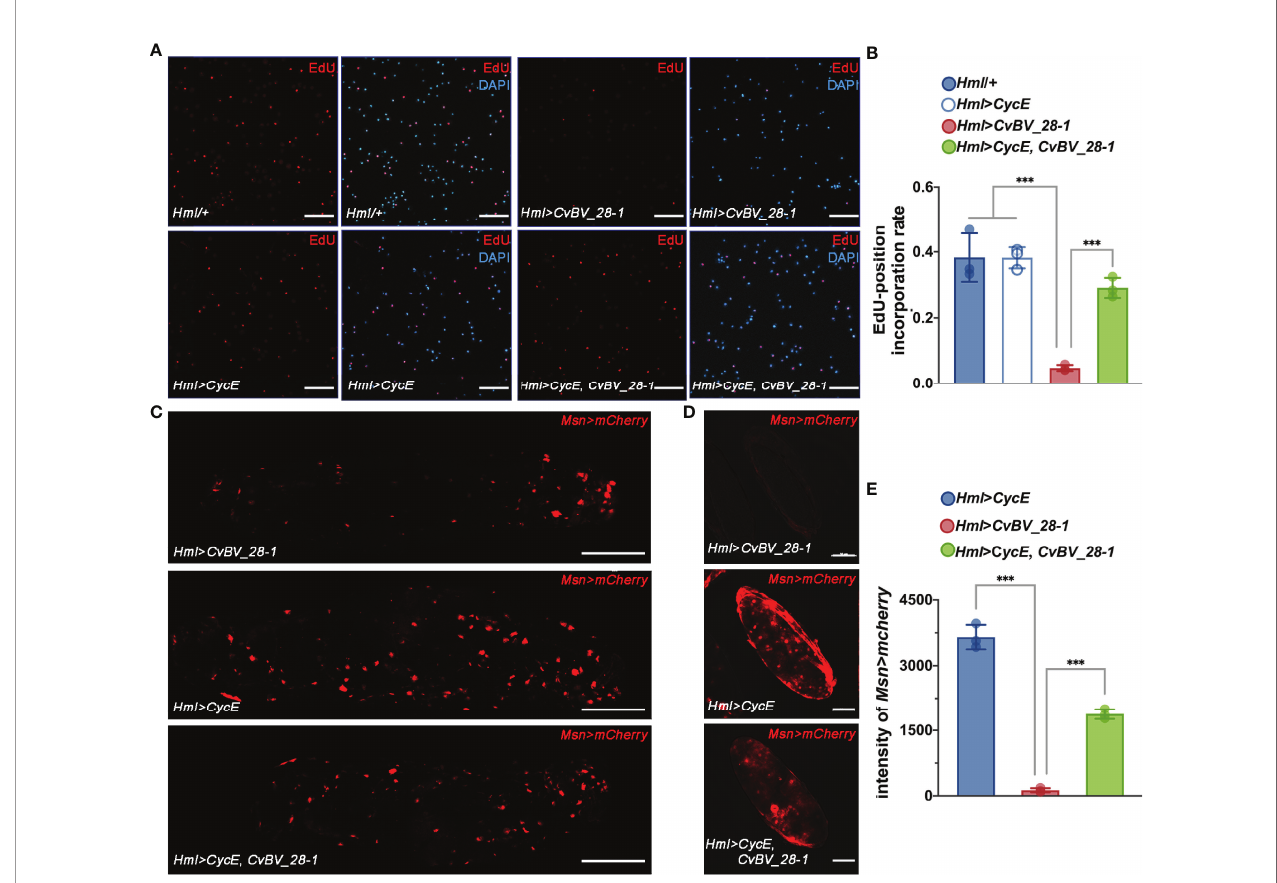
FIGURE 5 | CvBV_28-1 inhibits hemocyte proliferation in parasitized hosts. (A) EdU incorporation assay of hemocytes in Drosophila larvae ectopically expressing CvBV_28-1 and CycE in hemocytes ( Hml>CycE, CvBV_28-1 ) 48 h post- L. boulardi parasitization. Drosophila larvae with the Hml-GAL4 driver only or ectopically expressing only CycE or CvBV_28-1 in hemocytes ( Hml/+ , Hml>CycE or Hml>CvBV_28-1 ) served as controls. EdU was stained with EdU-Alexa 594 (red), and the nuclei were labeled with DAPI (blue). Representative images from three independent replicates are displayed. Scale bars: 50 µm. (B) Quanti fi cation of EdU staining in hemocytes of Drosophila larvae ectopically expressing CvBV-28-1 and CycE in hemocytes ( Hml>CycE, CvBV-28-1 ) 48 h post- L. boulardi parasitization. Drosophila larva with the Hml-GAL4 driver only or ectopically expressing only CycE or CvBV_28-1 in hemocytes ( Hml/+ , Hml>CycE or Hml>CvBV_28-1 ) served as controls. Three independent biological replicates were performed and shown as dots. Data are presented as the mean values ± SD. Differences between groups were analyzed by one-way ANOVA with Tukey ’ s multiple comparisons test (***p < 0.001). (C) Image of a whole Drosophila larva ectopically expressing CvBV_28-1 and CycE in hemocytes ( Hml>CycE, CvBV_28-1 ) 48 h post- L. boulardi parasitization; lamellocytes are shown in red ( MsnCherry ). Drosophila larvae ectopically expressing only CvBV_28-1 or CycE in hemocytes ( Hml>CvBV_28-1 or Hml>CycE ) served as controls. Representative images out of three independent replicates are displayed. Scale bars: 500µm. (D) Image of a wasp egg dissected from a Drosophila larva ectopically expressing CvBV_28-1 and CycE in hemocytes ( Hml>CycE, CvBV_28-1 ) 48 h post- L. boulardi parasitization; lamellocytes are shown in red ( MsnCherry ). Wasp eggs dissected from Drosophila larvae ectopically expressing only CvBV_28-1 or CycE in hemocytes ( Hml>CvBV_28-1 or Hml>CycE ) served as controls. Representative images from three independent replicates are displayed. Scale bars: 50 µm. (E) Quanti fi cation of lamellocytes in Drosophila larvae ectopically expressing CvBV_28-1 and CycE in hemocytes ( Hml>CycE, CvBV_28-1 ) 48 h post- L. boulardi parasitization. Drosophila larvae ectopically expressing only CvBV_28-1 or CycE in hemocytes ( Hml>CvBV_28-1 or Hml>CycE ) served as controls. Three independent biological replicates were performed and shown as dots. Data are presented as the mean values ± SD. Differences between groups were analyzed by one-way ANOVA with Tukey ’ s multiple comparisons test (***p <